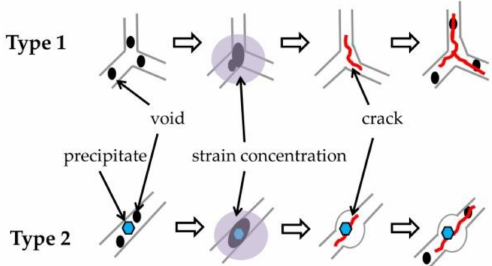
Figure 11. Schematic diagram of the formation process of ductility dip